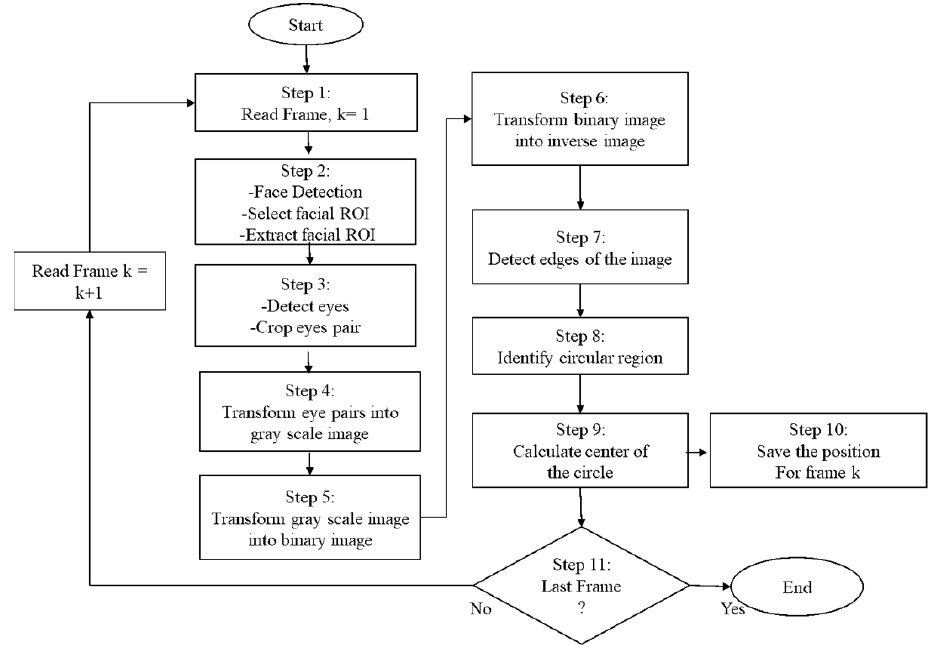
Figure 3. Flow chart of the method for eye positions extraction.